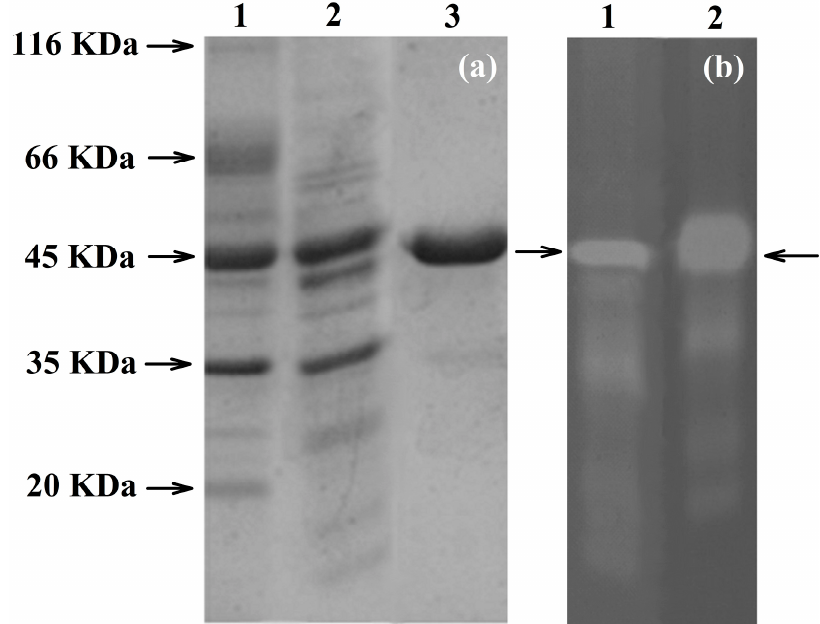
Figure 3. Electrophoretic analyses of PhyRC001 phytase purified from red rice crop residues and castor bean cake. ( a ) SDS-PAGE, 1: Molecular weight marker (kDa); 2: spin column portion of partly purified phytase (crude extract); 3: purified phytase; and ( b ) zymogram analysis of PhyRC001 phytase, 1: crude extract showing opaque region in native gel (arrow); 2: purified phytase showing opaque region in native gel (arrow).